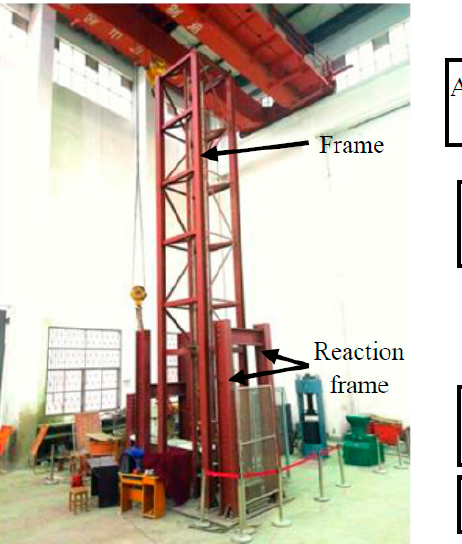
Figure 11. The steel tube.